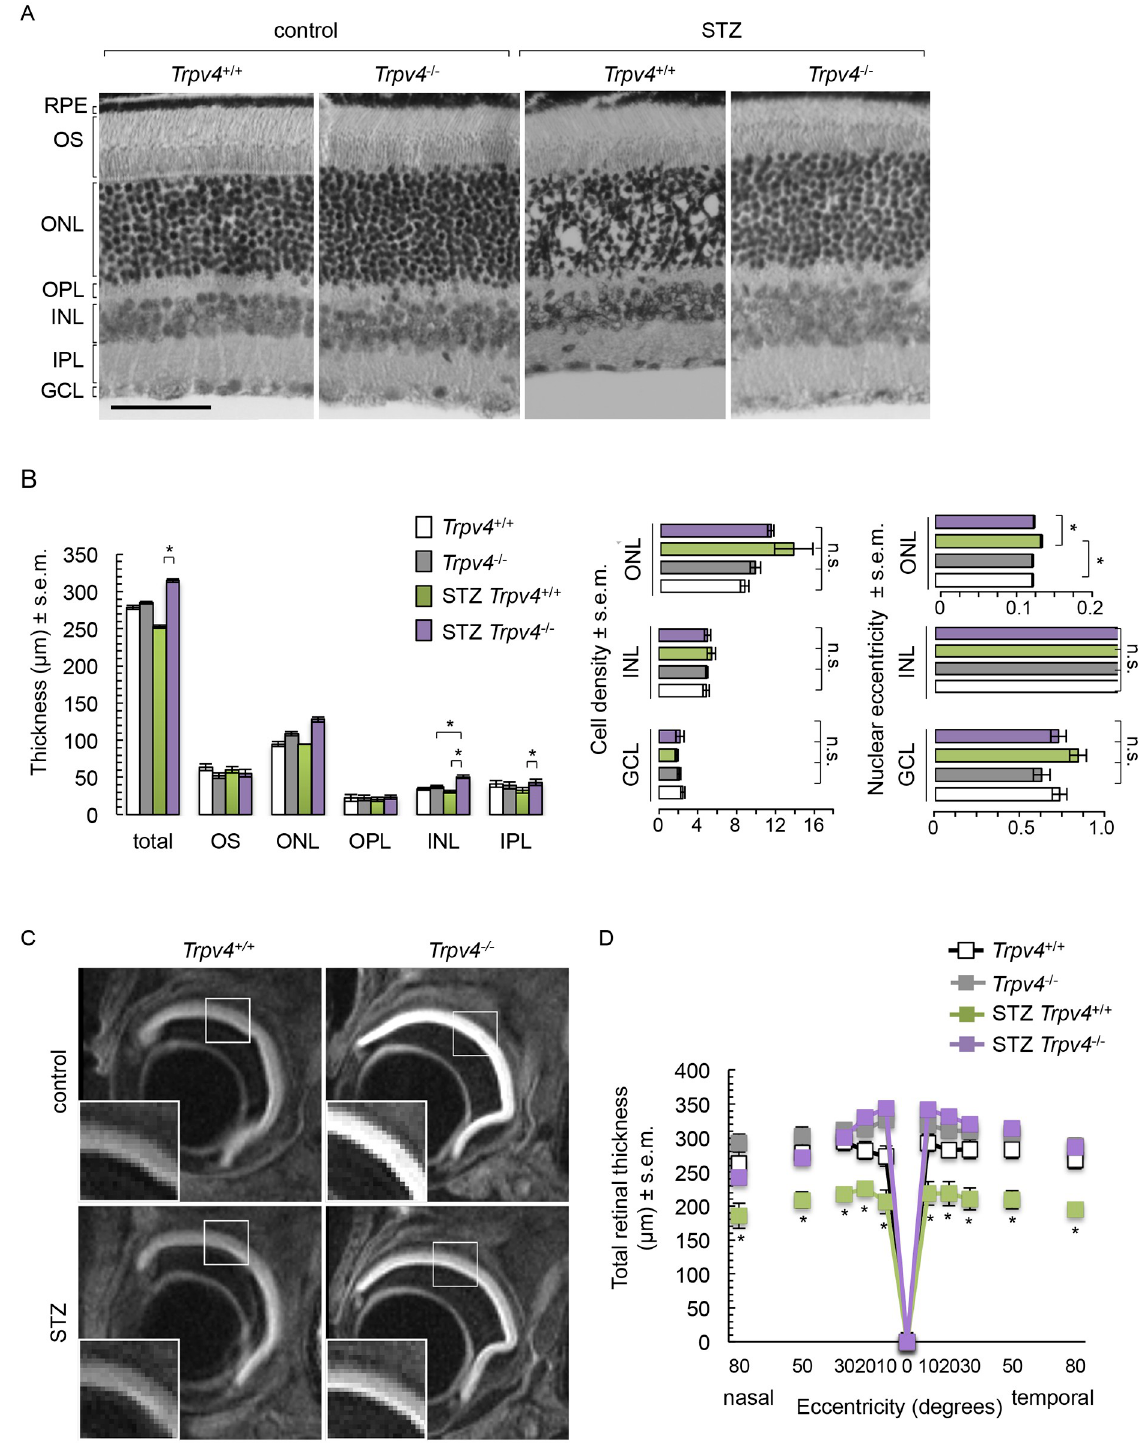
Fig 1. Retinal morphometry analysis in nondiabetic (control) and diabetic (STZ) wild-type ( Trpv4 +/+ ) and Trpv4 -/- mice. ( A ) Representative images of hematoxylin/eosin-stained retinas and ( B ) corresponding quantification of retinal thickness, cell density per mm 2 , and nuclear eccentricity. Retinal pigment epithelium (RPE), outer segments (OS), outer nuclear layer (ONL), outer limiting membrane (OLM), outer plexiform layer (OPL), inner nuclear layer (INL), inner plexiform layer (IPL), and ganglion cell layer (GCL). From each of six animals per group, three equally distributed sections (300 μ m x 100 μ m) throughout the entire retina were analyzed. Scale bar, 100 μ m. ( C )